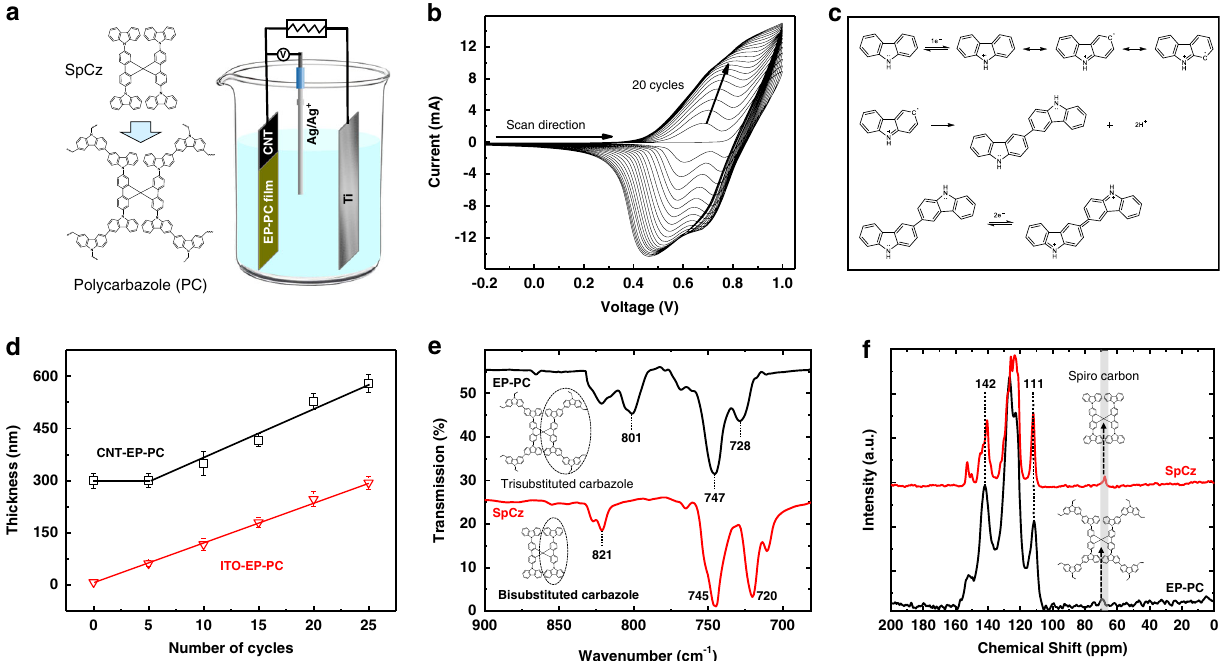
Fig. 2 Membrane preparation and chemical structure. a The setup of a three-electrode electrochemical cell for the electropolymerization process. b CV pro fi les of the electropolymerization process recorded for 20 scan cycles. c Mechanism of monomer oxidation, crosslinking, and reduction during the CV scans. d Membrane thickness vs. the number of CV scans. e FT-IR spectra of monomer SpCz and CNT-EP-PC15 membrane. f 13 C CP-MAS of monomer SpCz and CNT-EP-PC15 membrane.